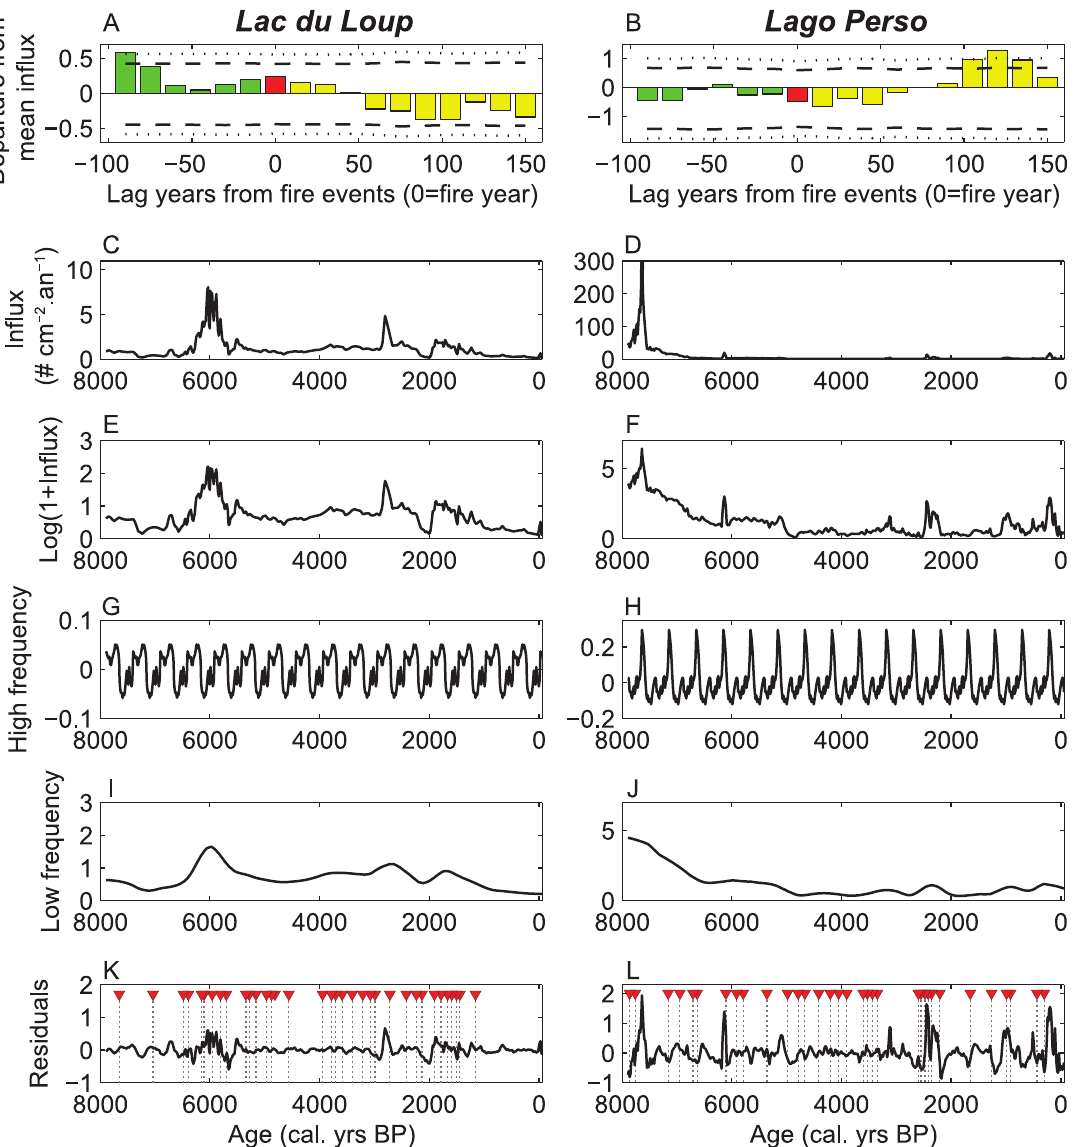
Figure 1. Superposed Epoch Analysis (SEA) technique outline. SEA results applied to the sum of transformed total macroremain influxes for Lac du Loup (A) and Lago Perso (B). Pre- and post-fire transformed means of macroremains influx are colored in green and yellow, respectively; times of fires are in red, with 95% and 99% confidence intervals (CI) of means given by dashed and dotted lines, respectively. (C,D) The sum of raw macroremain influxes for the two sites and, (E,F) the sum of transformed macroremain influxes (see Material and Methods for details on mathematical formula). (G,H) High and (I,J) low frequency trends in macroremain influx sum decomposed from LOESS fitting. (K,L) Residuals from LOESS decomposing used to perform SEA, where triangles ( = in red) and dashed lines give the date of reconstructed fire